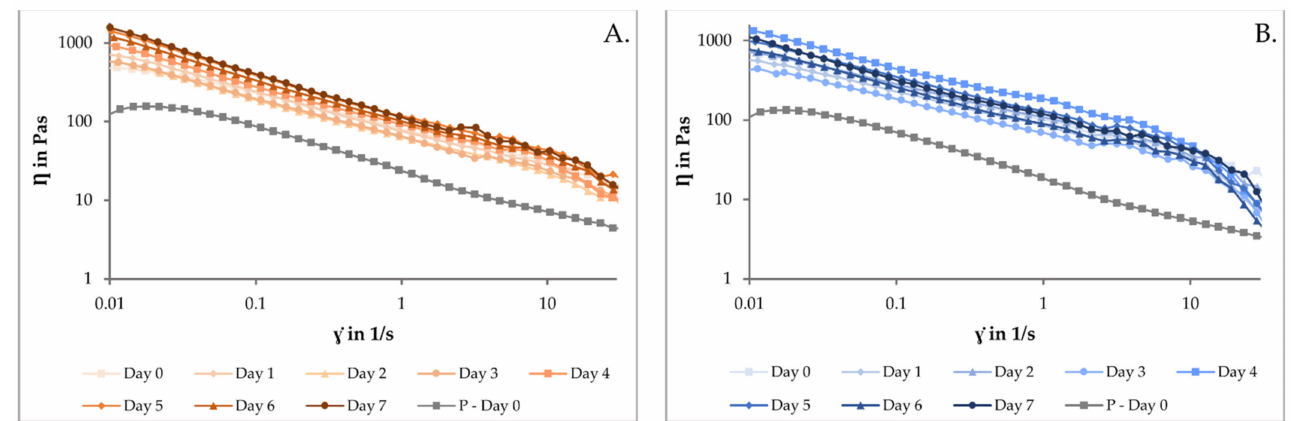
Figure 1. Viscosity vs. shear rate curves was measured on the day of preparation and daily for a week after preparation. Solutions stored at room temperature are visualized in orange ( A ), and solutions stored at fridge temperature are visualized in blue ( B ). Corresponding drug-free placebo solution was measured only on the day of preparation; it is visualized in gray in both figures and marked with “P” for